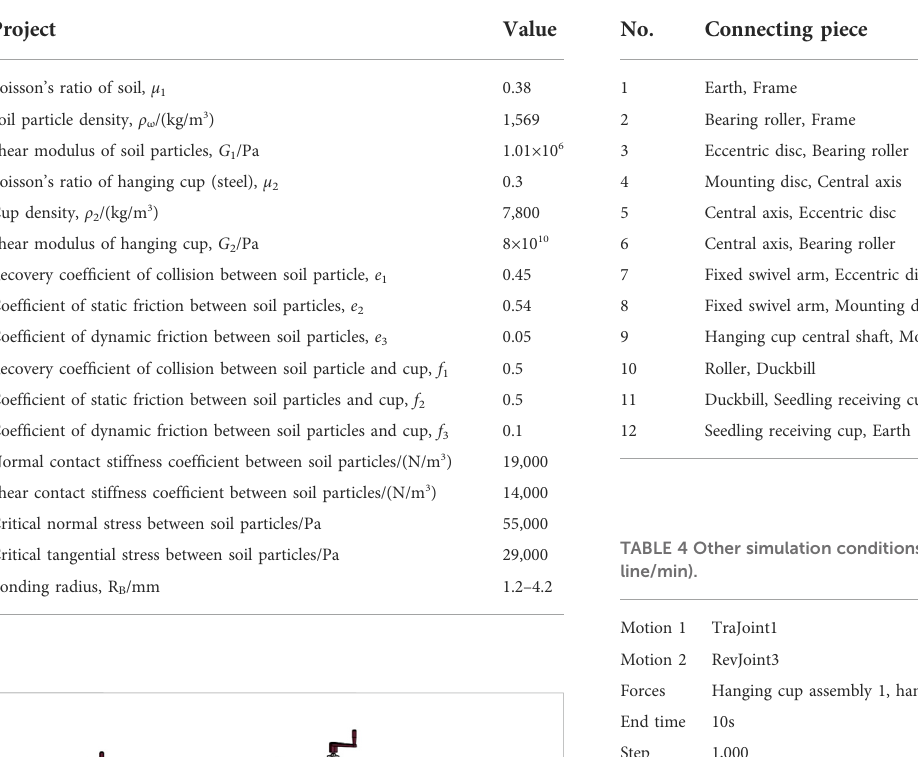
TABLE 2 Parameter table of discrete element simulation.